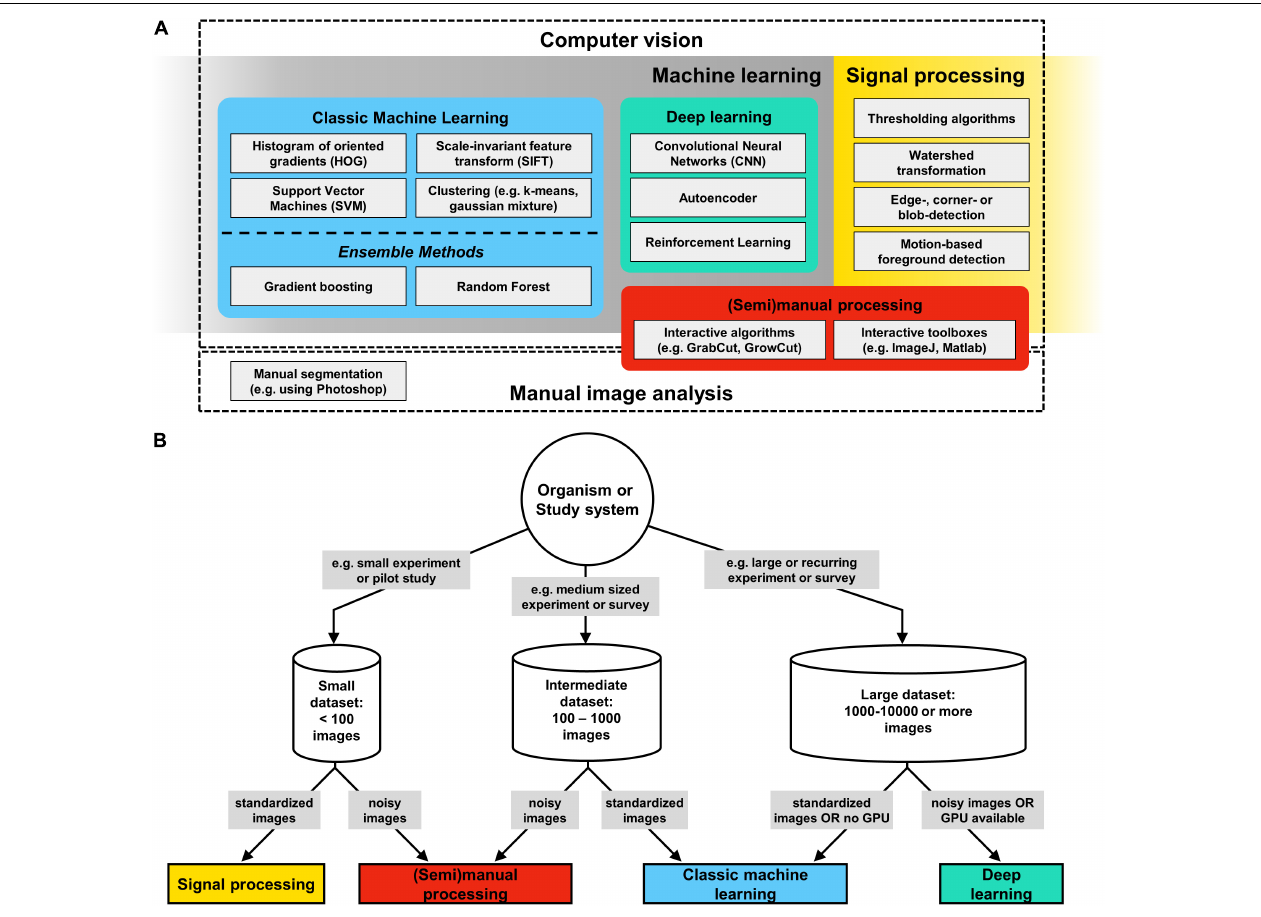
FIGURE 4 | Computer vision (CV) methods overview. (A) CV is a field at the intersection of machine learning and signal processing which is concerned with the automatic and semiautomatic extraction of information from digital images. (B) Decision tree for CV methods: begin by considering the size of a given image